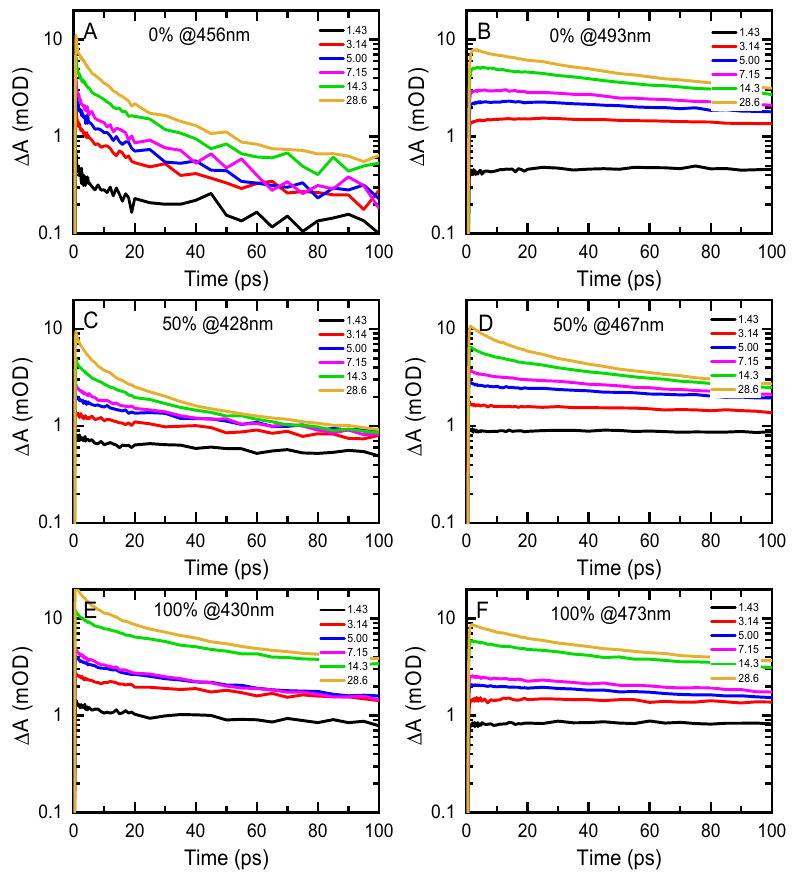
Figure 5. Time evolution of transient absorption in perovskite films with a 0% ( A , B ), 50% ( C , D ), and 100% ( E , F ) excess of RbBr at varying excitation-pulse energy densities shown in μ J/cm 2 . The selected wavelengths correspond to the peak of the GSB band from the n = 3 domain in the 0% sample ( A ), n = 2 domain in the 50% and 100% samples ( C , E ), and the emitting n ≥ 4 domain ( B , D , F ).